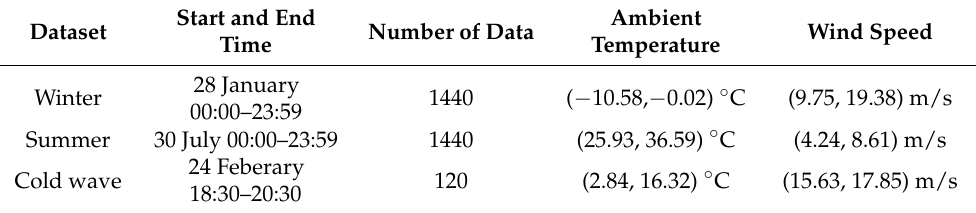
Table 3. Description of datasets under different weather conditions.